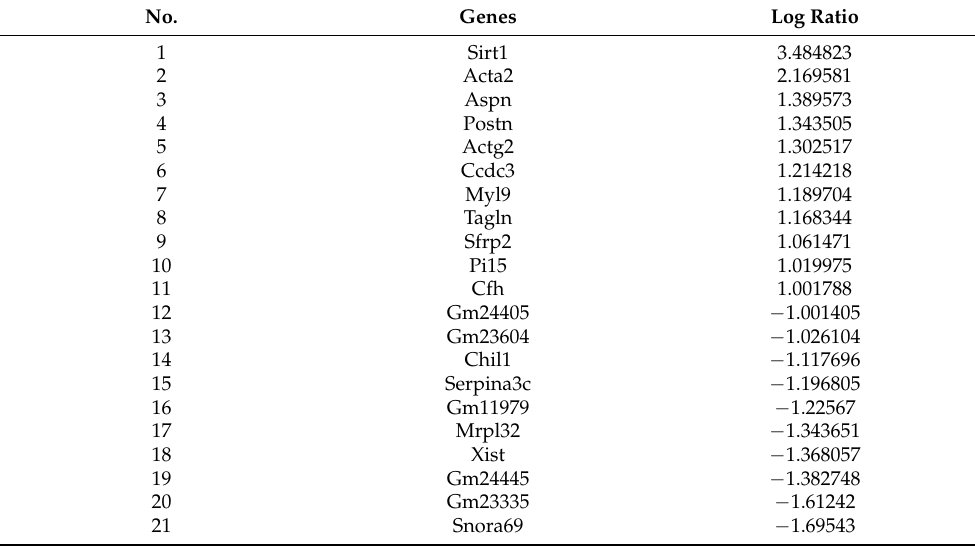
Table 1. Differentially regulated genes (2-fold) in control mice and SIRT1-KI mice.